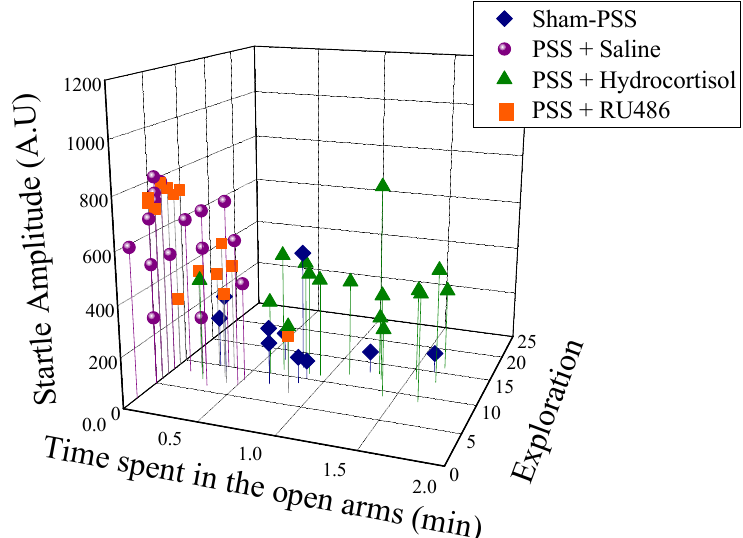
Figure 9. High-dose hydrocortisone, saline or RU486 early post-exposure on behavioral stress responses at day 7 post-exposure: Three-dimensional parameters: The X-axis represents time spent in the open arms (min), the Y-axis represents acoustic startle amplitude (A.U), and the Z-axis—total exploration on the maze. Circles (purple) represent the exposed group that treated with Saline ( n = 16), which exhibited a significant degree of anxiety-like and avoidant behaviors on the elevated plus-maze and a pattern of exaggerated startle responses with significantly reduced habituation 7 days after exposure (PTSD-like phenotype). Triangles (green) represent the exposed group that treated with Hydrocortisone 25 mg/kg ( n = 16), which exhibited minimal or partial behavioral response patterns. Diamonds (blue) represent the sham-PSS-exposed control group ( n = 10). Squares (orange) represent the exposed group that treated with RU486 30 mg/kg ( n = 14), which exhibited extreme or partial behavioral response patterns.